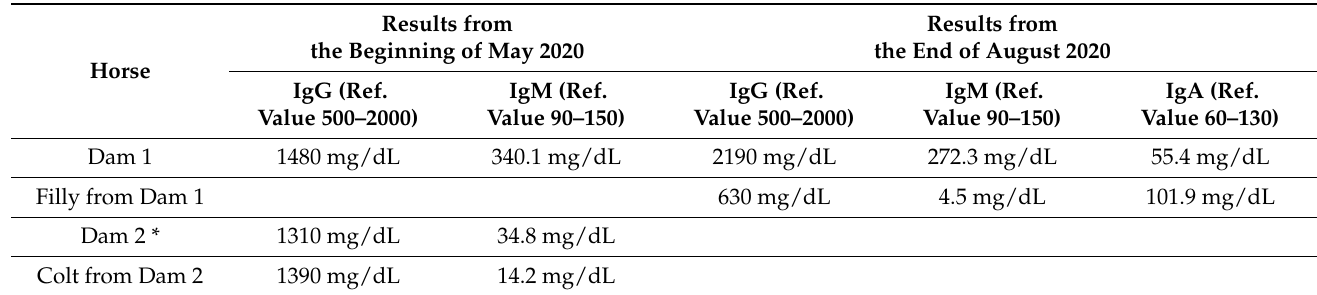
Table 1. Results of immunoglobulin levels investigation. The Ig reference values for foals above 60 days of life are the same as for adult